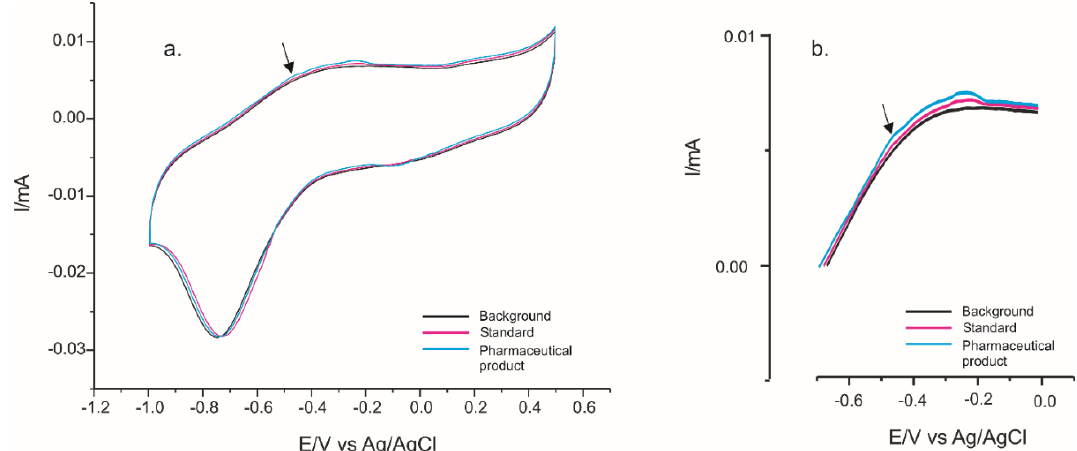
Figure 13. ( a ) Cyclic voltammograms of the PPy/FeCN sensor in solution KCl solution (background), L-Tyr solution (standard spike, 2 × 10 − 6 M), Cebrium spike solution (estimated total concentration 4 × 10 − 6 M of L-Tyr). ( b ) Zoom of the cyclic voltammograms in the zone of L-Tyr detection. Table 9. The quantitative results obtained for L-Tyr detection in pharmaceuticals by the standard addition method. Pharmaceutical Product [Tyr]/M Added I vs. [Tyr] Equation [Tyr]/M Found Recovery (%) Cebrium EVER NEURO